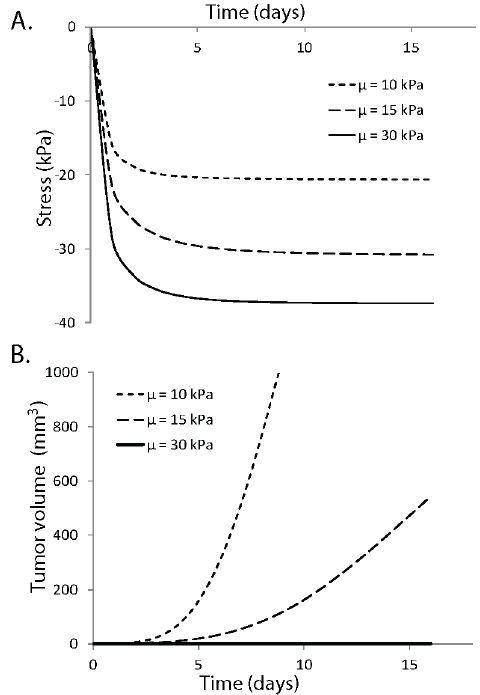
Figure 5. Effect of tumor constitutive behavior on tumor growth and state of stress. A) Model fit to the experimentally measured growth curve of SW620 tumors using the neo-Hookean and the exponential equation. B) Evolution of bulk solid stress in the tumor interior does not depend on the selection of the constitutive equation. Results using the Blatz-Ko material are omitted for clarity.